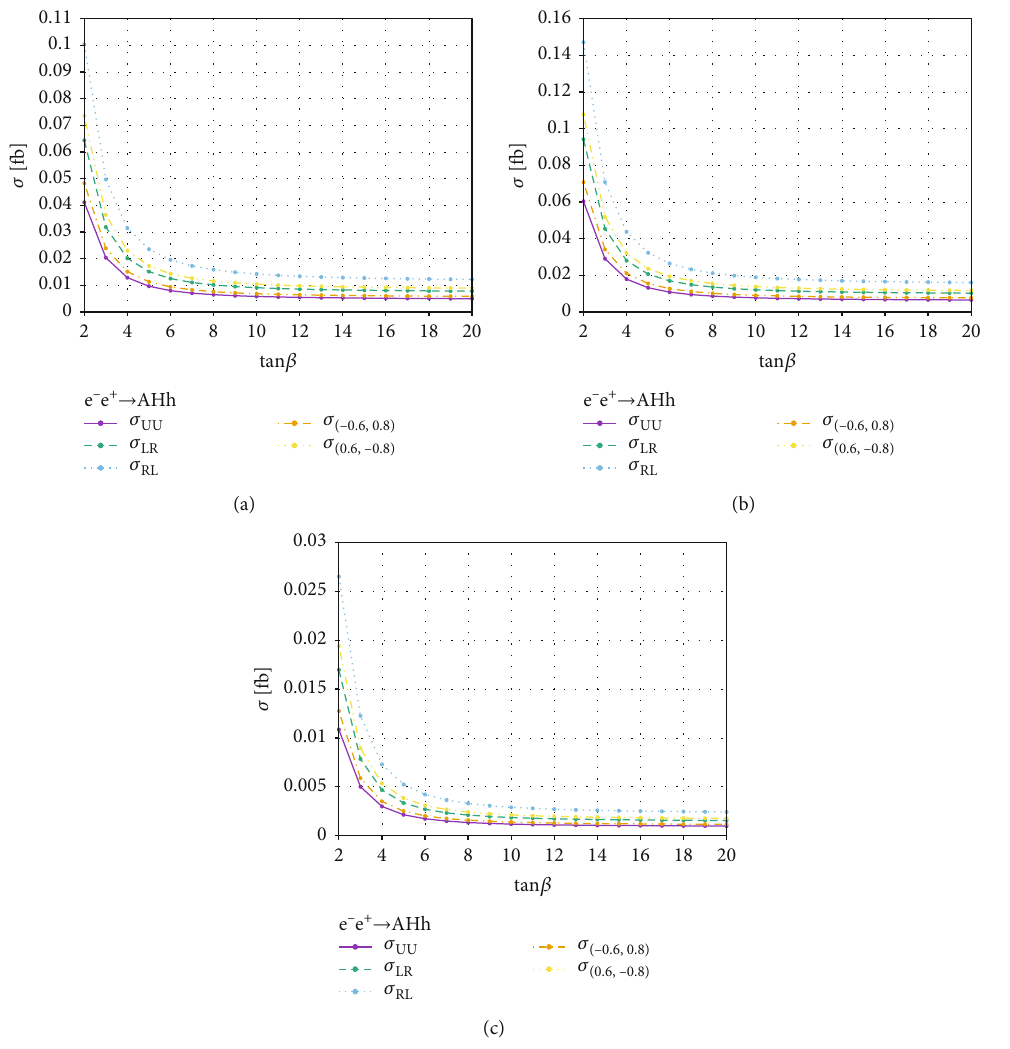
ffiffi p = 0 : 6 TeV , (b) s